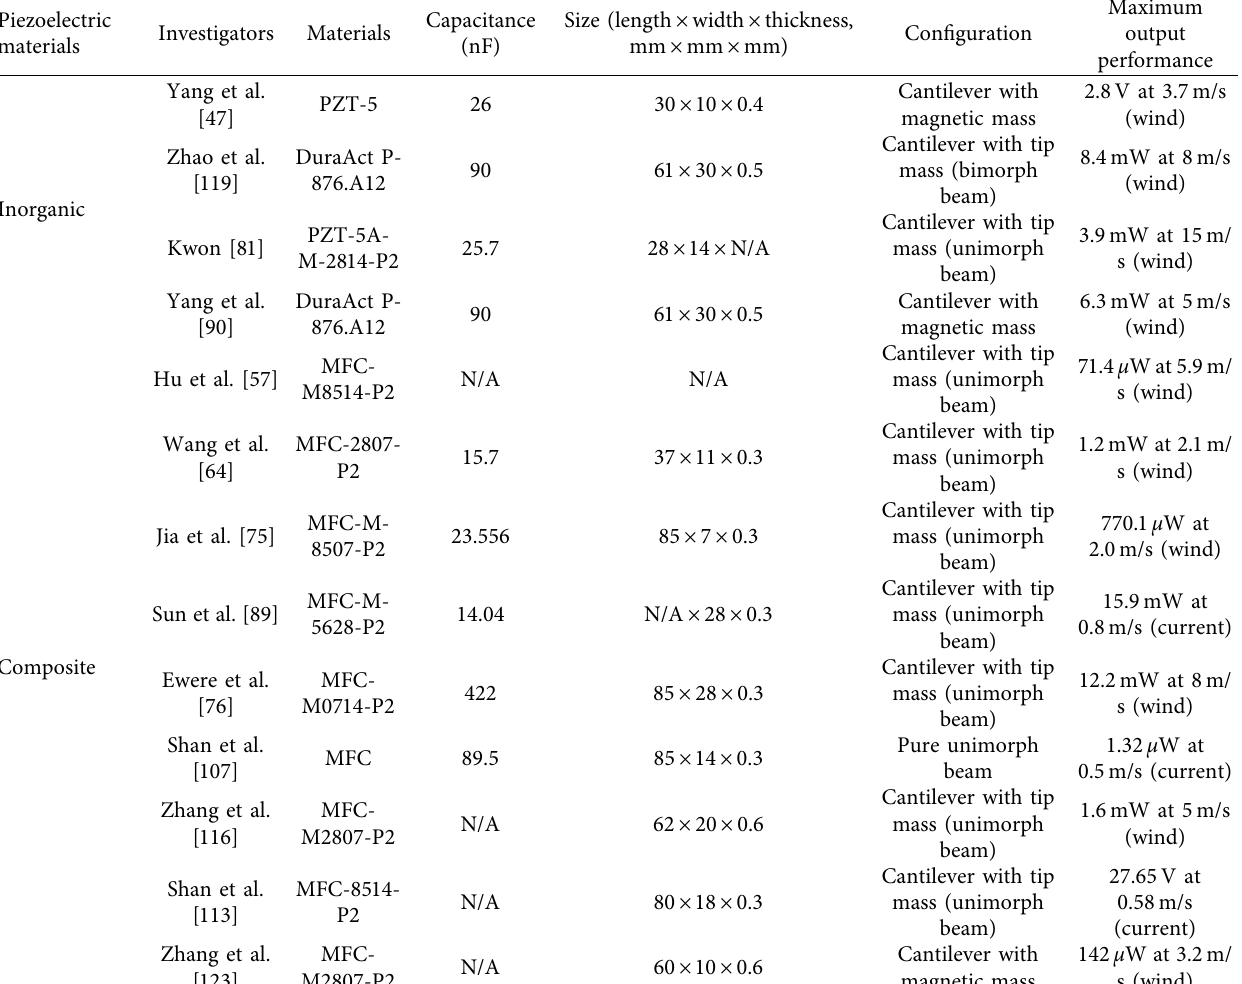
Table 5: Summary of piezoelectric materials and associated devices reported in the previous literature.